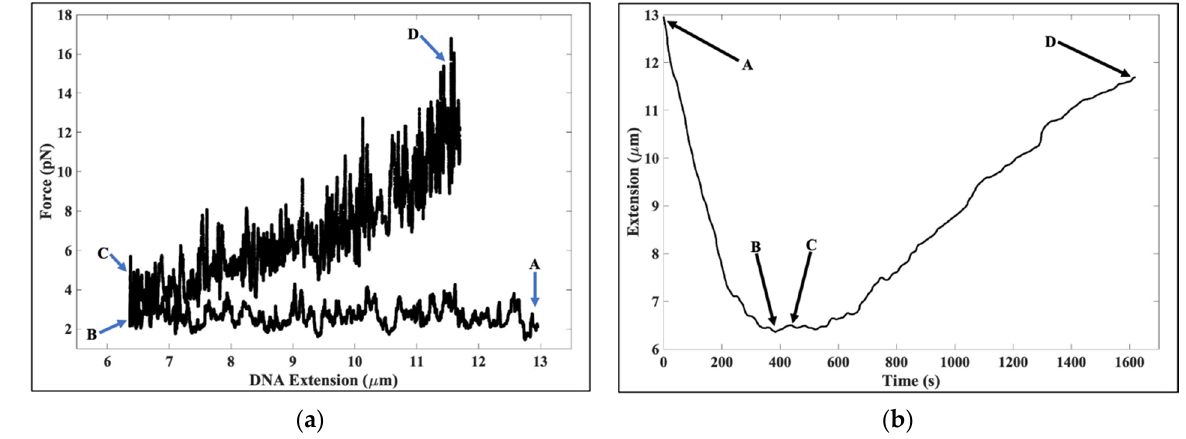
Figure 2. ( a ) The arrows from A to B show the region where upon binding to histones, the length of the λ -DNA decreases from ~12.8 μ m to ~6.4 μ m at forces ranging from ≈ 2.2 pN at A to ≈ 2.7 pN at B. The arrows from B to C indicate the region where the forces were slowly increased from ~2.7 pN to ~3.3 pN, with the corresponding change in DNA extension from ~6.4 μ m to ~6.5 μ m. The arrows from C to D demarcate the region where the DNA tether was subject to forces from ≈ 3.3 pN to ≈ 12.5 pN, with the corresponding DNA extension increasing from ~6.5 μ m to ~11.7 μ m. ( b ) Extension vs. time for the data in part ( a ). Arrow A corresponds to a DNA extension of ~12.8 μ m, arrow B corresponds to a DNA extension of ~6.4 μ m, arrow C corresponds to a DNA extension of ~6.5 μ m, and arrow D corresponds to a DNA extension of ~11.7 μ m. In regions A to B, we moved the magnet away from the λ -DNA at speeds between 0.5 μ m/s and 1 μ m/s. In regions B to D, we moved the magnet towards the tethered DNA at a speed of 0.5 μ m/s.